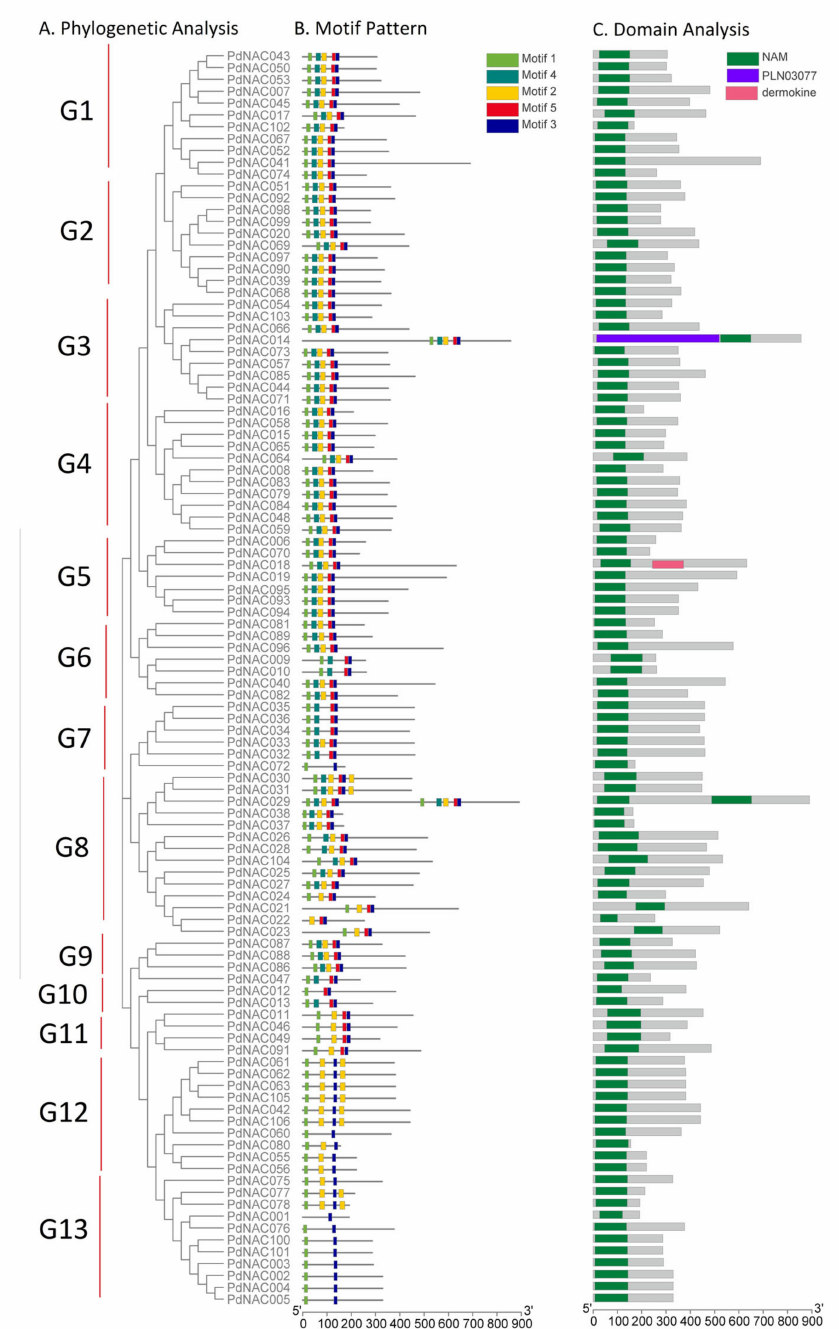
Figure 4. Gene structure and motif analysis of PdNAC. ( A ) Phylogenetic tree, ( B ) motif pattern, and ( C ) domain presence. Gene structure shows the presence of introns and exons in the